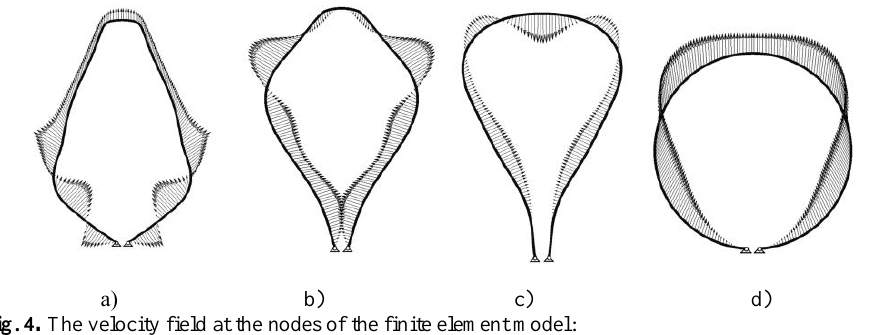
Fig. 4 . The velocity field at the nodes of the finite element model: а) t  11.0 s; b) t  12.7 s; c) t  13.5 s; d) t  60.9 s